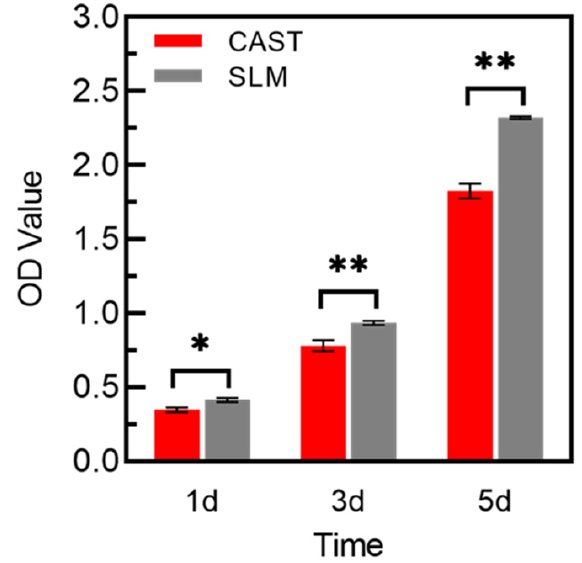
Figure 8. CCK-8 assay of L-929 cells cultured on the samples for 1, 3, and 5 d (* p < 0.05, ** p < 0.01).